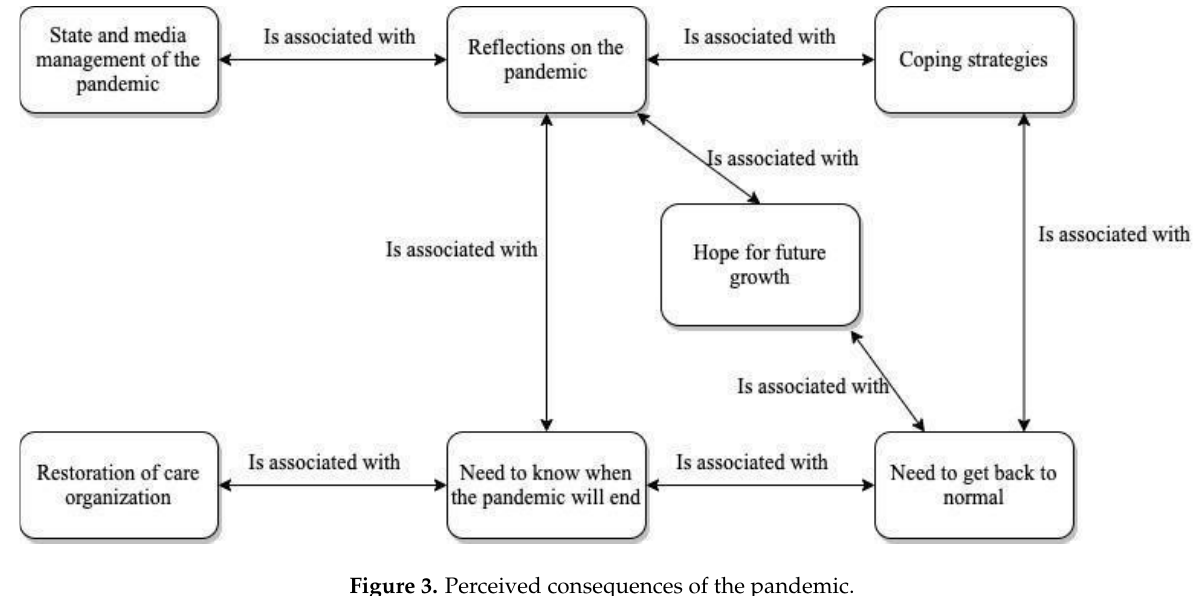
Figure 3. Perceived consequences of the pandemic.